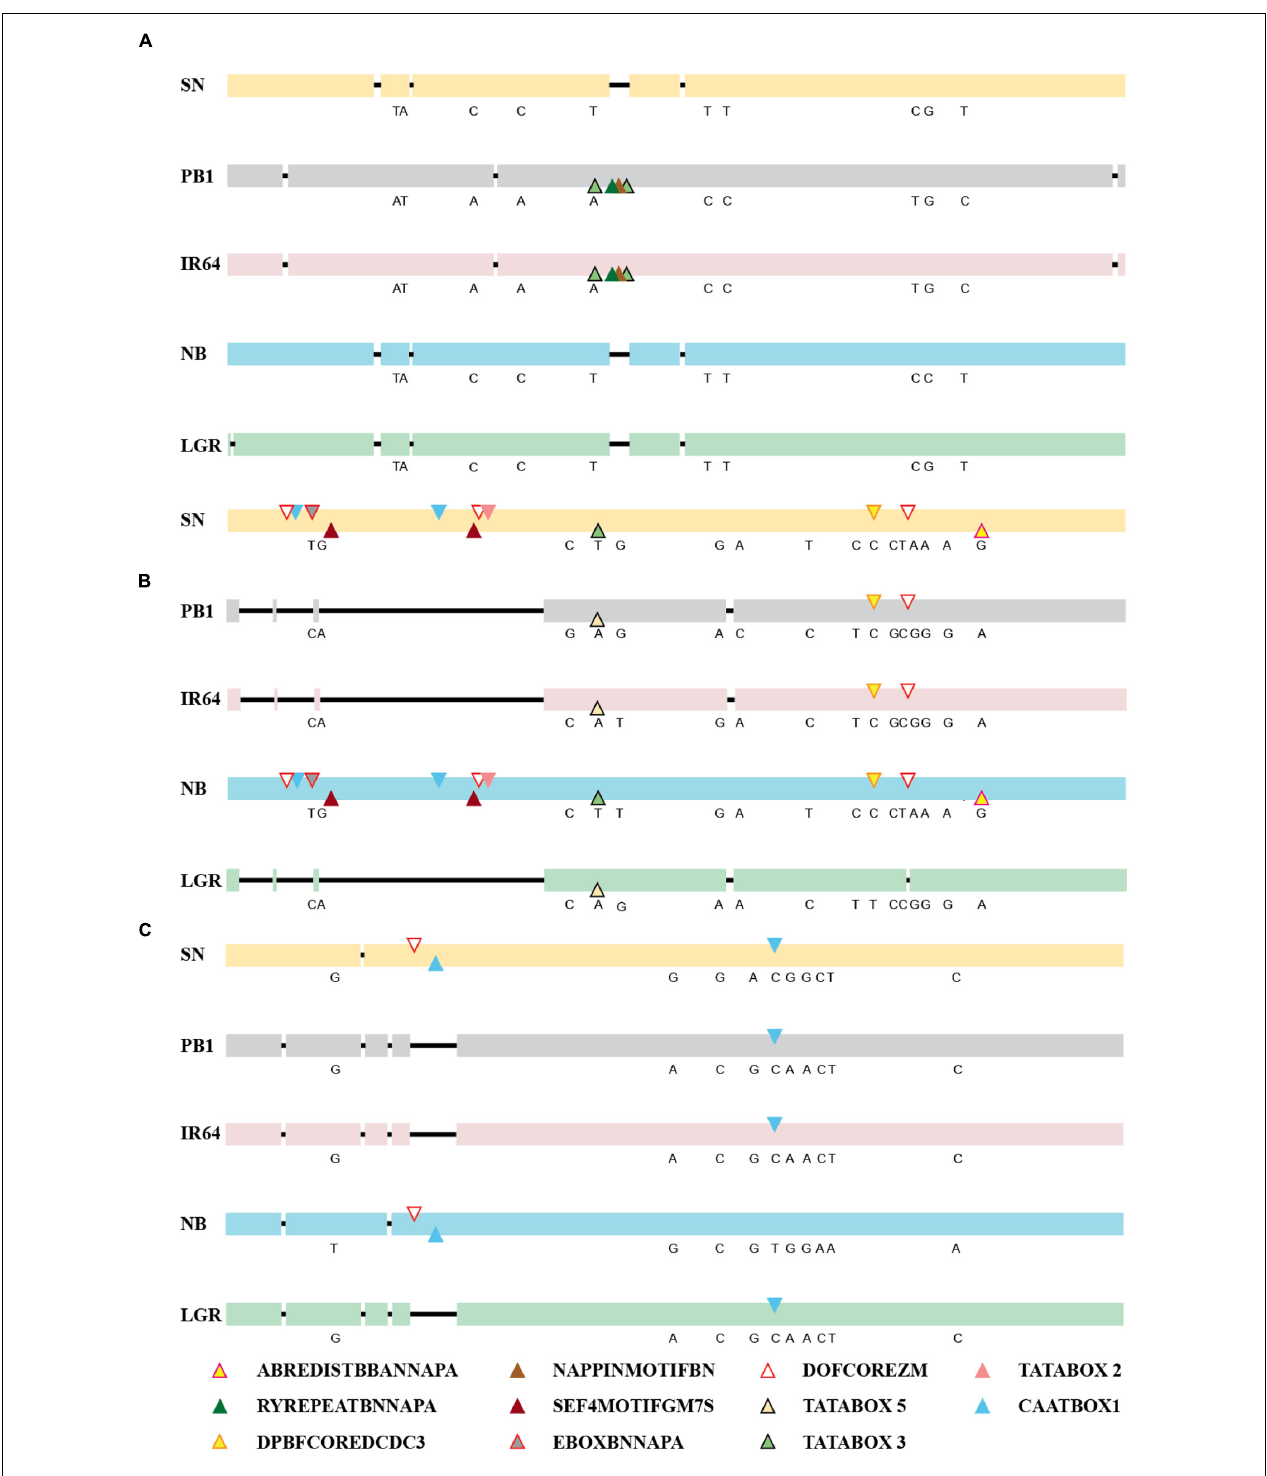
FIGURE 3 | Alignments of the promoter sequences of (A) ONAC020 , (B) ONAC026, and (C) ONAC023 in five accessions of rice, namely SN, PB1, IR64, NB, and LGR. The deletions have been shown by a black line. The SNPs among the accessions have been written in their corresponding positions (Supplementary Tables S3 and S4). Seed-specific elements with changes amongst different accessions (Supplementary Tables S5 and S6) have been marked with colored triangles, as per the color legend. The promoter elements identified on the positive strand have been marked on the upper side and those on the negative strand, on the lower side. In longer stretches of deletion, in ONAC026 and ONAC023 , repeatedly occurring elements in 300 and 75 bp stretches, respectively, have been represented only once by their respective triangles.